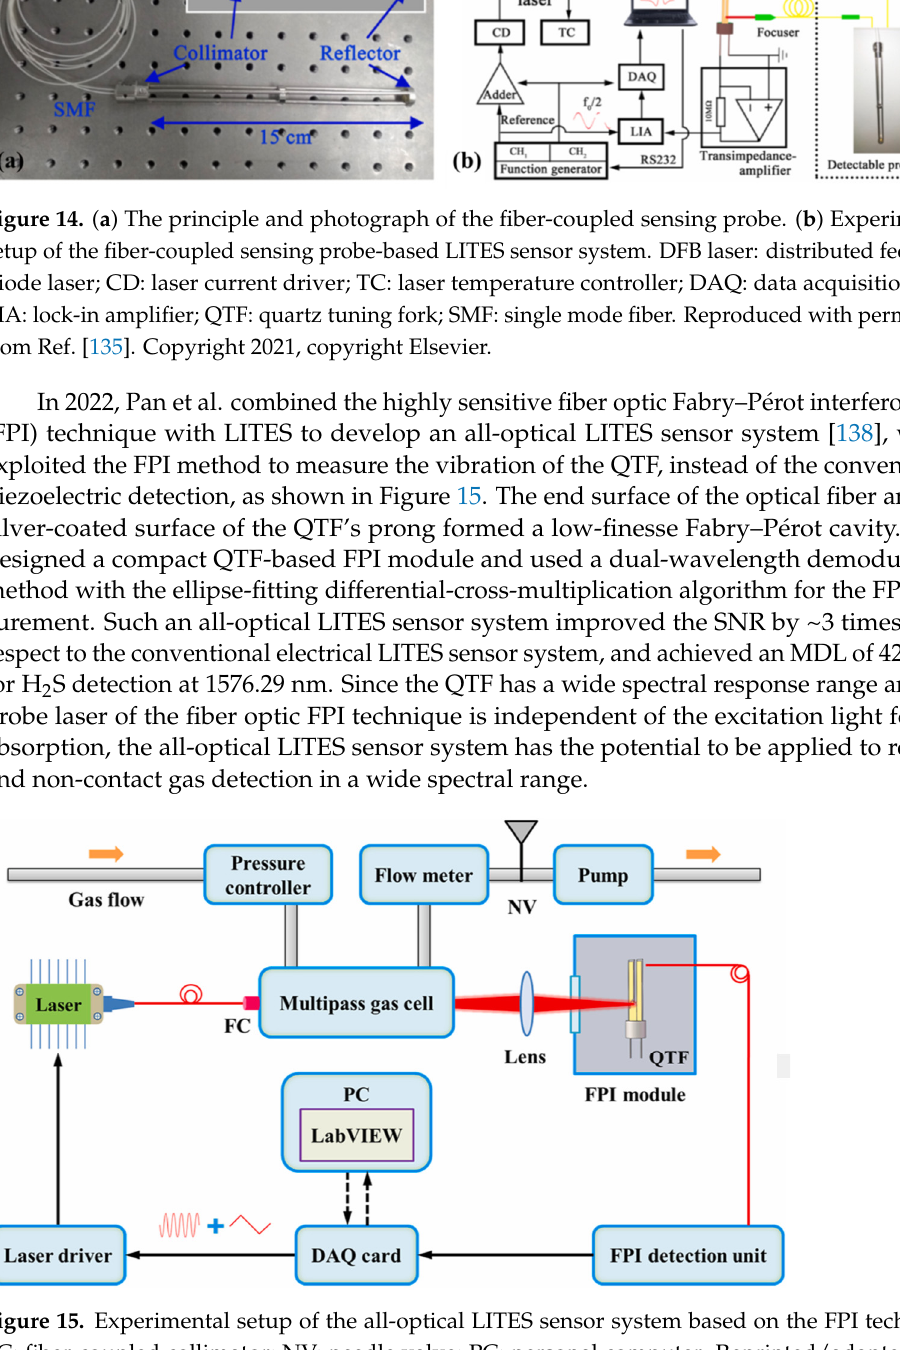
12 of 21 Figure 13. ( a ) A scanning electron microscope (SEM) image of the HC-PCF. ( b ) Experimental setup of the all-fiber LITES sensor system. TC: temperature controller; CD: current driver; DFB laser: distributed feedback diode laser; CH: channel; SMF: single-mode fiber; HC-PCF: hollow-core photonic crystal fiber; QTF: quartz tuning fork; TA: trans-impedance amplifier; LIA: lock-in am- plifier. Reprinted/adapted with permission from Ref. [69]. Copyright 2020, copyright The Optical Society. In 2021, Hu et al. proposed another optical fiber-based LITES sensing method [135], which used a fiber-coupled sensing probe, as shown in Figure 14a. The fiber-coupled structure was realized by two SMFs (input and output) and two FC/APC (Ferrule con- tactor/angle physical contact) connectors with a 0.25 dB connection loss. The experi- mental setup of the fiber-coupled sensing probe-based LITES sensor system is shown in Figure 14b. They exploited a near-infrared DFB diode laser to detect CH 4 at 1653.72 nm. The incident laser from the input SMF was collimated by a fiber-coupled collimator and reflected by a reflector to another fiber-coupled collimator. Then, the laser was coupled to